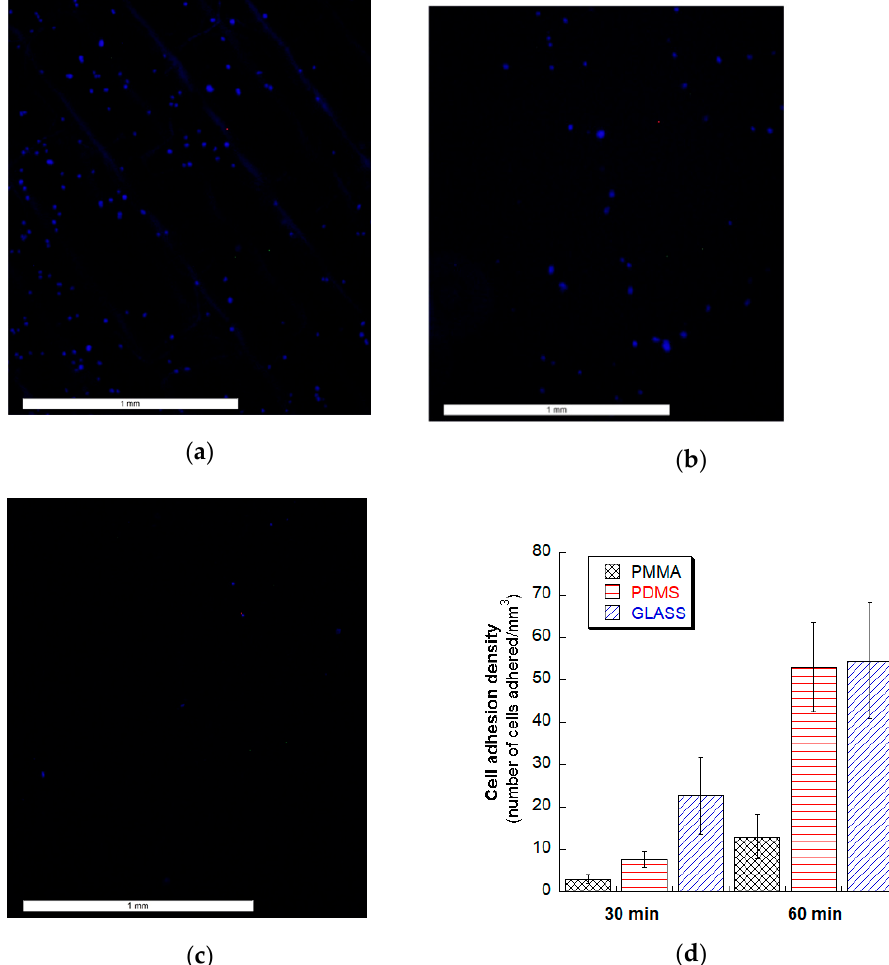
Figure 7. Human fibroblast cell adhesion test for 30-min incubation time for laser-machined microchannels on ( a ) glass, ( b ) PDMS, and ( c ) PMMA. ( d ) Quantified cell density on glass, PDMS and PMMA substrate with laser-machined microchannels for 30 min and 60 min incubation time.